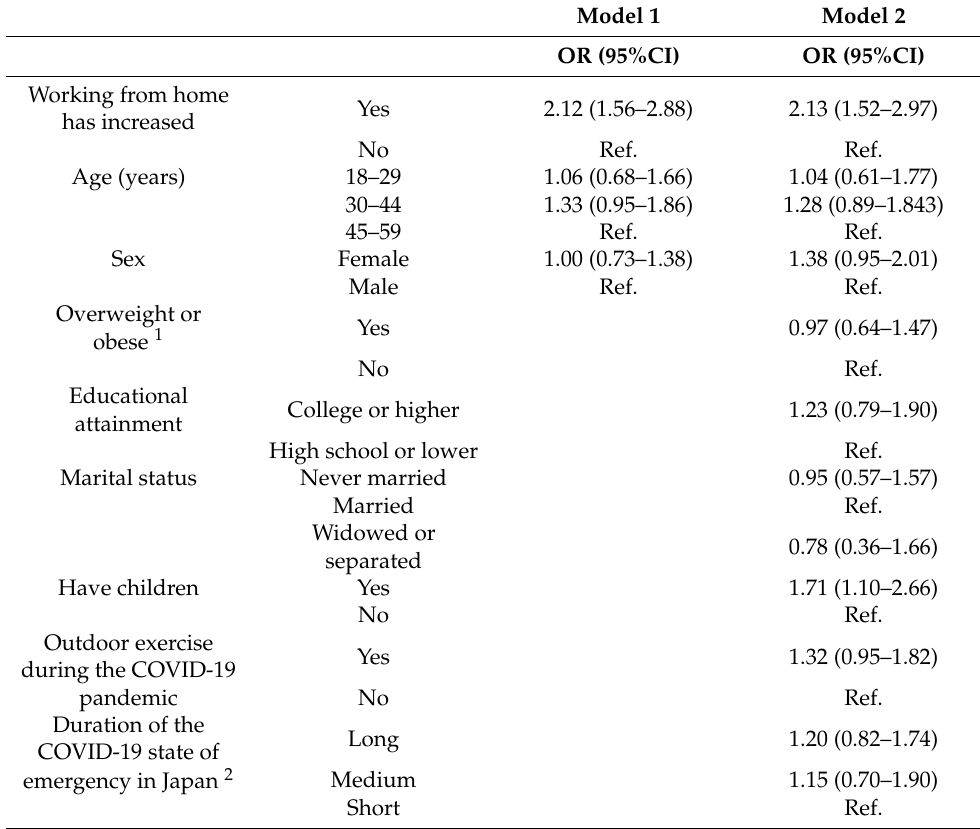
Table 2. Association between increased work from home and LBP during the COVID-19 pandemic among the desk